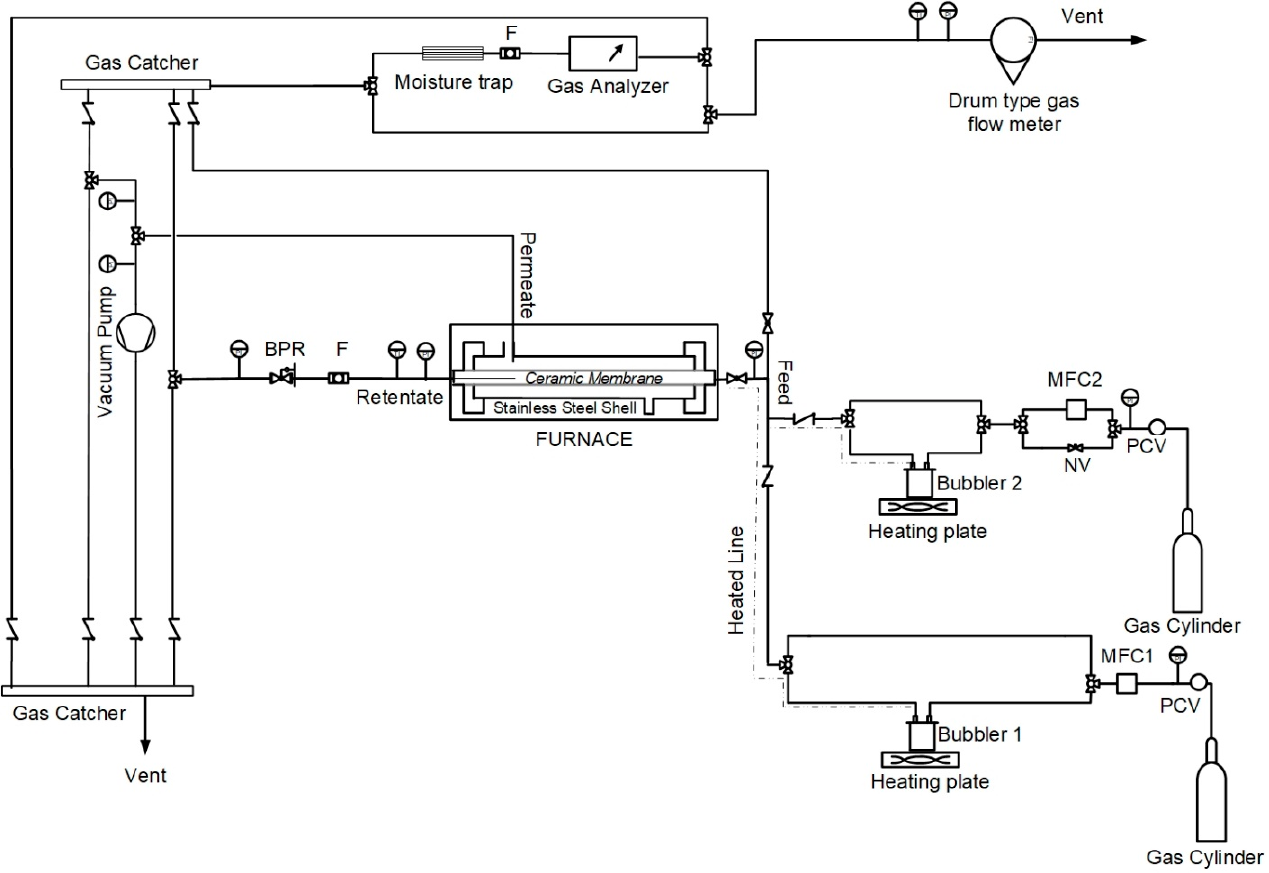
Figure 1. Process and Instrumentation Diagram (P&ID) of the experimental unit.